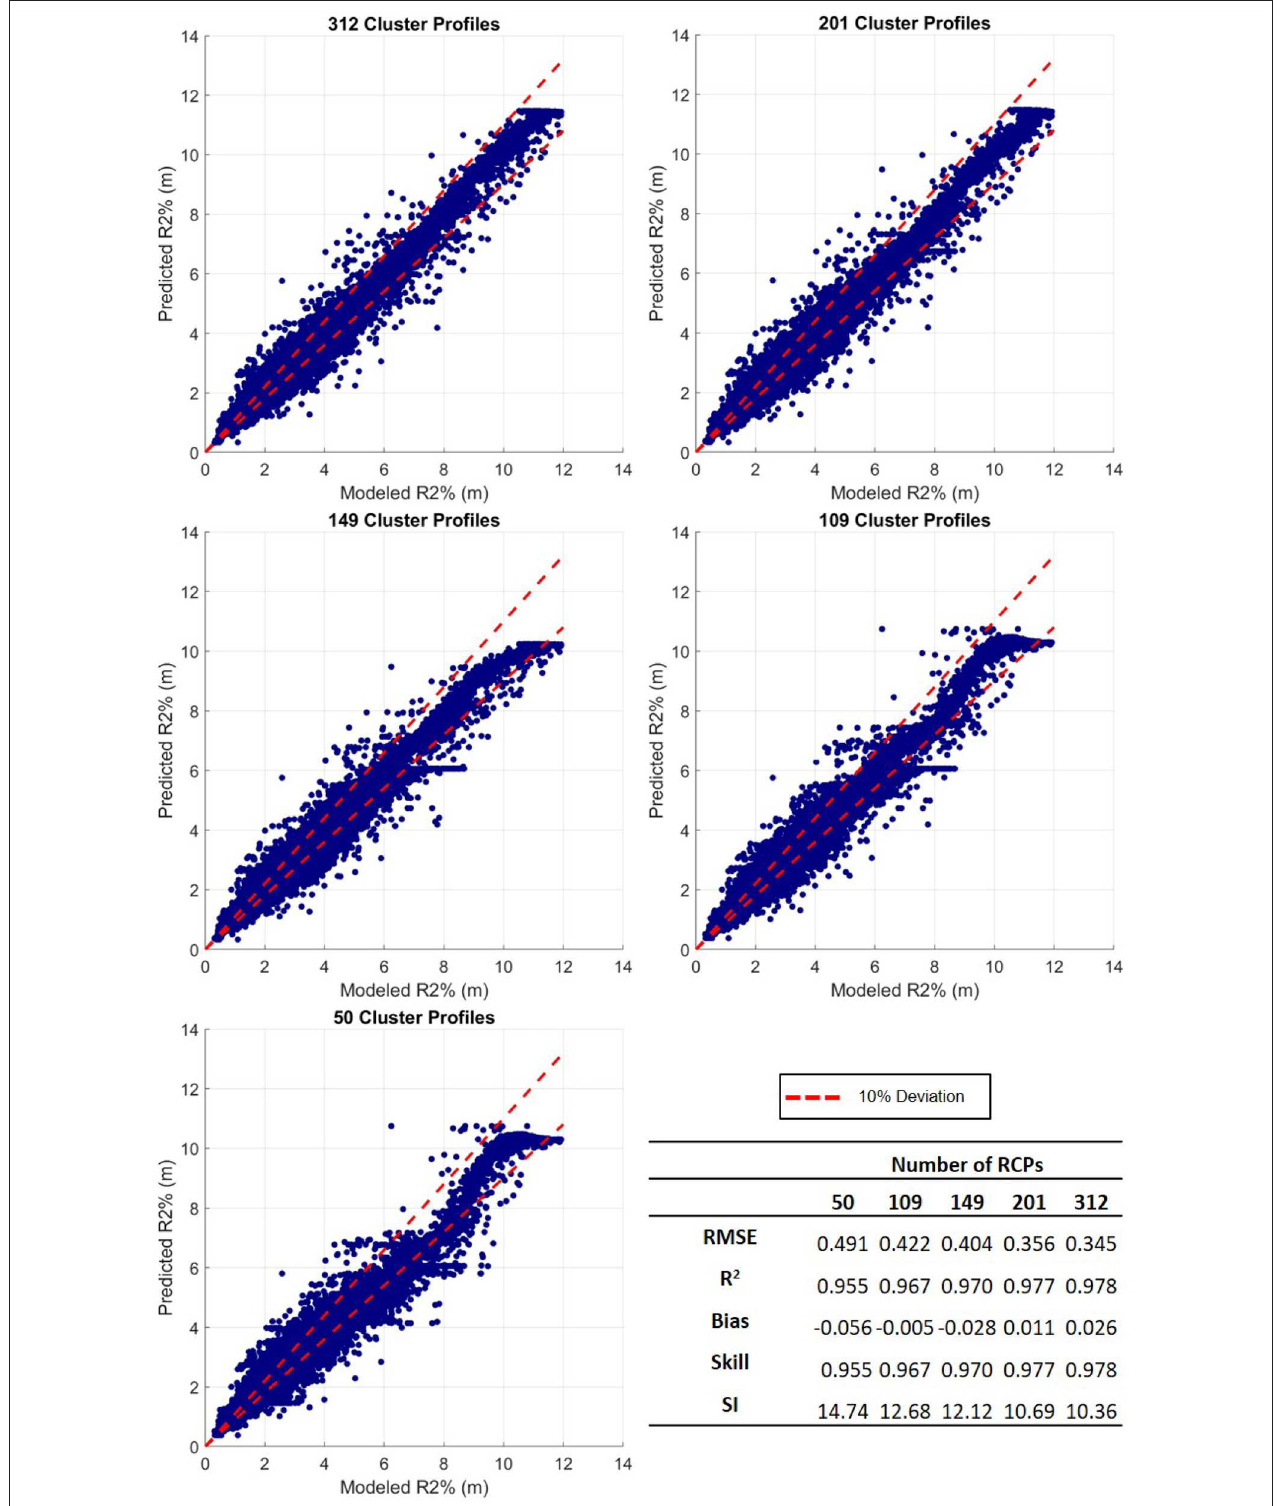
FIGURE 11 | Modeled vs. estimated R 2 % for the five different numbers of representative cluster profiles (RCPs), ranging from 312 (top left) to 50 (bottom left). The table in the bottom right provides data comparison statistics, explained in section 3.5.2.